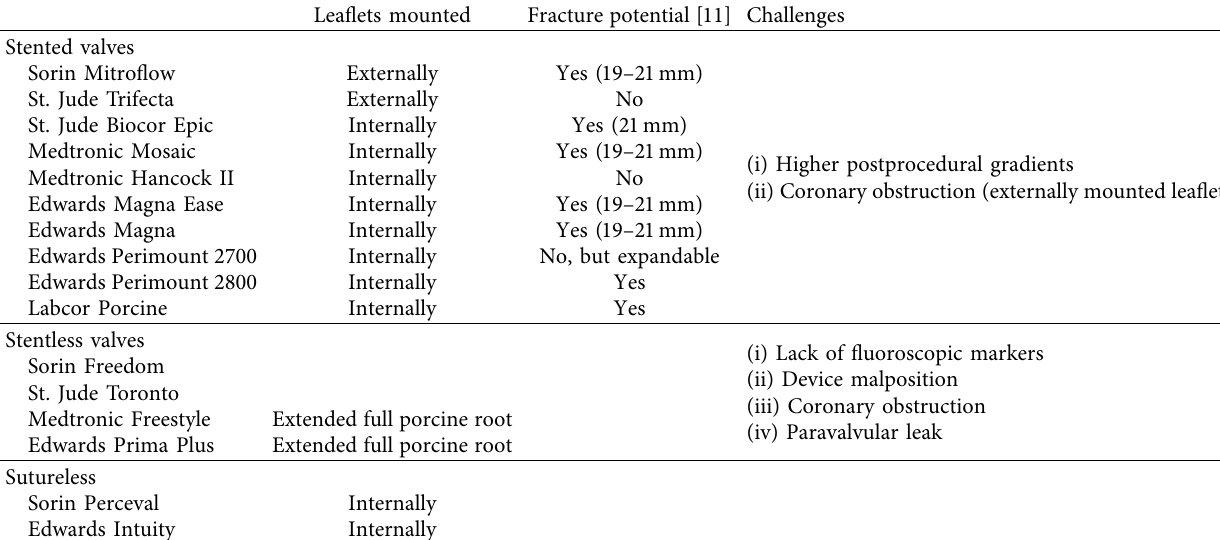
Table 1: Design, characteristics, and challenges of commonly used surgical aortic valves.